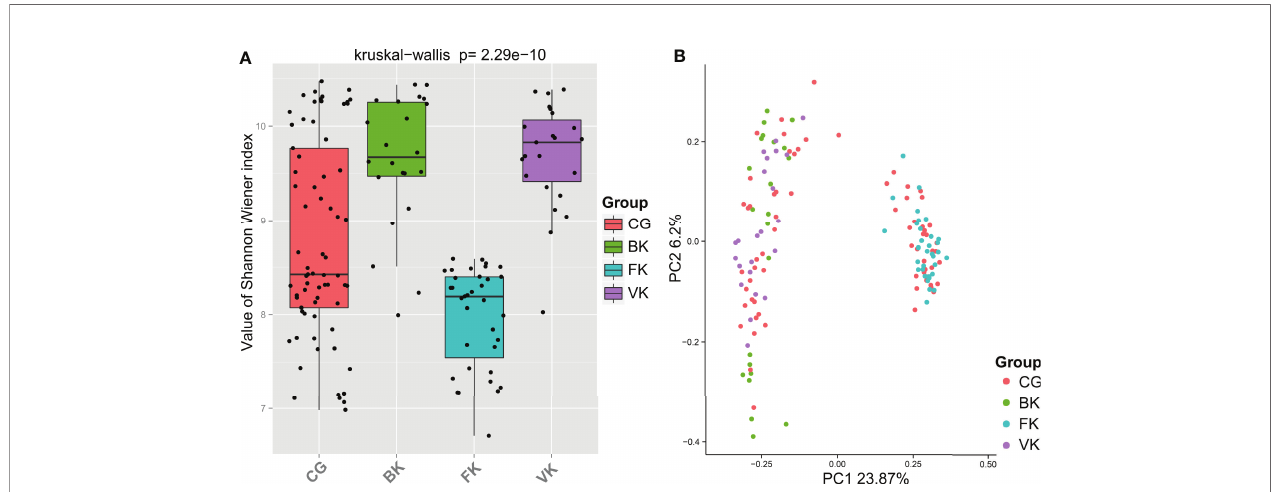
FIGURE 2 | For each speci fi c type of microbial keratitis, the ocular bacterial microbiota presents a unique community structure. (A) The Shannon – Wiener index re fl ects the species richness and evenness in a sample. (B) Based on dimensionality reduction, PCoA plots reveal similarities in community structure among microbiotas related to various types of microbial keratitis. (CG, control group - healthy eyes; BK, bacterial keratitis; FK, fungal keratitis; VK, viral keratitis).